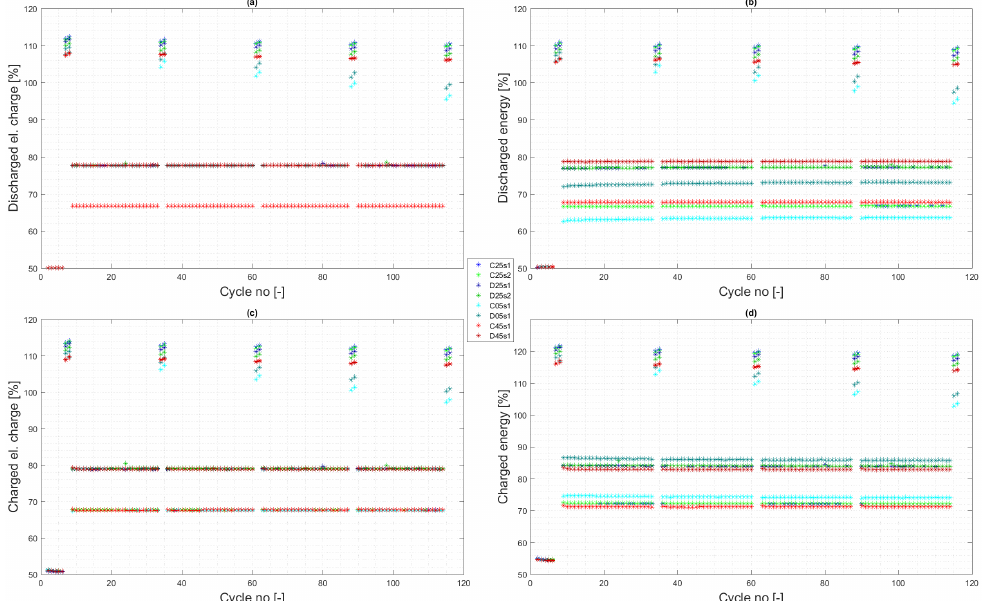
Figure 6. Measured values of electric charge during discharging ( a ) and charging ( c ), electric energy during discharging ( b ) and charging ( d ) for all the measured cycles and